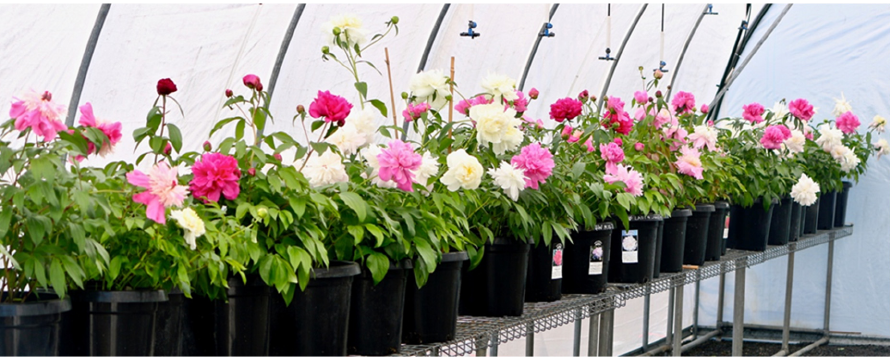
Figure 6. Peony plants in full bloom under subtropical conditions after being pre-treated from 20 °C to 8 °C, chilled at 4 °C, and treated with GA